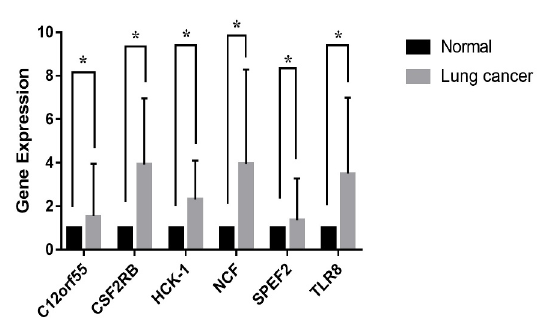
Figure 1. The Hub genes of C12orf55, CSF2RB, HCK-1, NCF, SPEF2 and TLR8 were analyzed by standard qRT-PCR approach and show the higher than normal group.